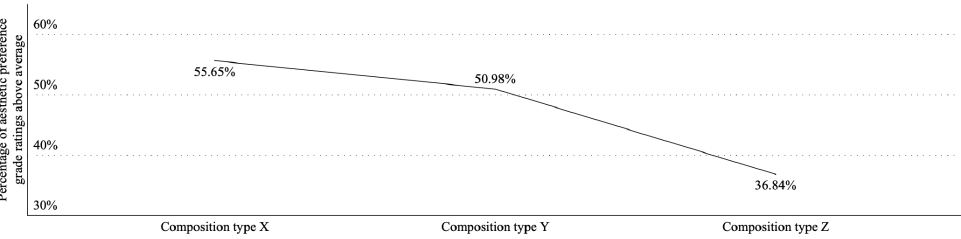
Figure 10. Percentage of aesthetic preference grade above